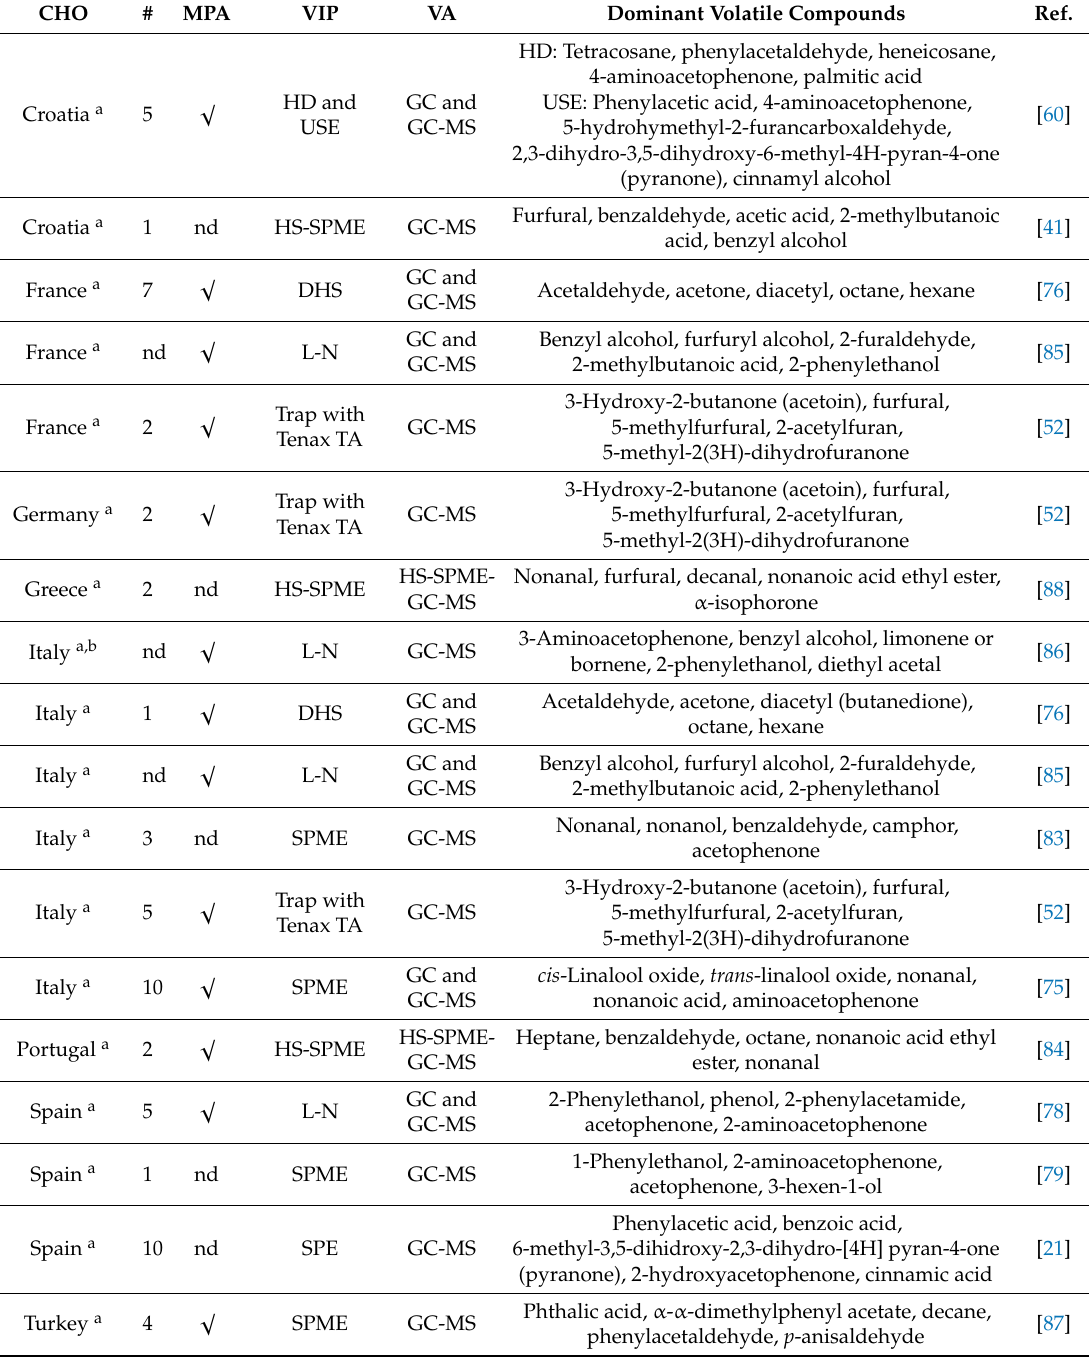
Table 4. Chestnut honey’s main volatiles, with reference to the country of origin, number of samples, isolation and analysis procedures and five main volatile components. Unless otherwise specified, the honeybee type was A. mellifera .